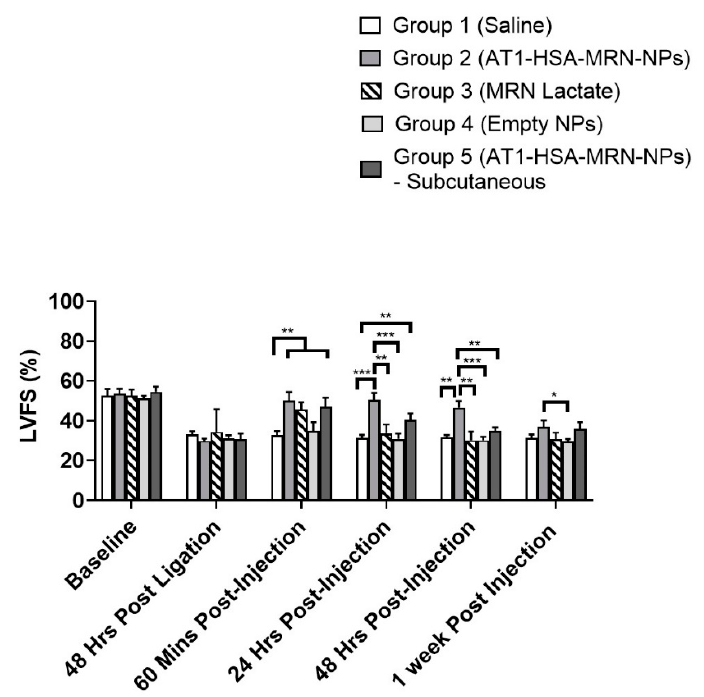
Figure 8. Percentage LVFS measurements for Groups 1, 2, 3, 4, and 5 at baseline, 48 h post ligation, 60 min, 24 h, 48 h, and 1-week post injections. The data have been presented as mean ± SD ( n = 5). *** p < 0.001 was considered highly significant and ** p < 0.01, * p < 0.05 was considered significant based on Tuckey’s post hoc analysis.